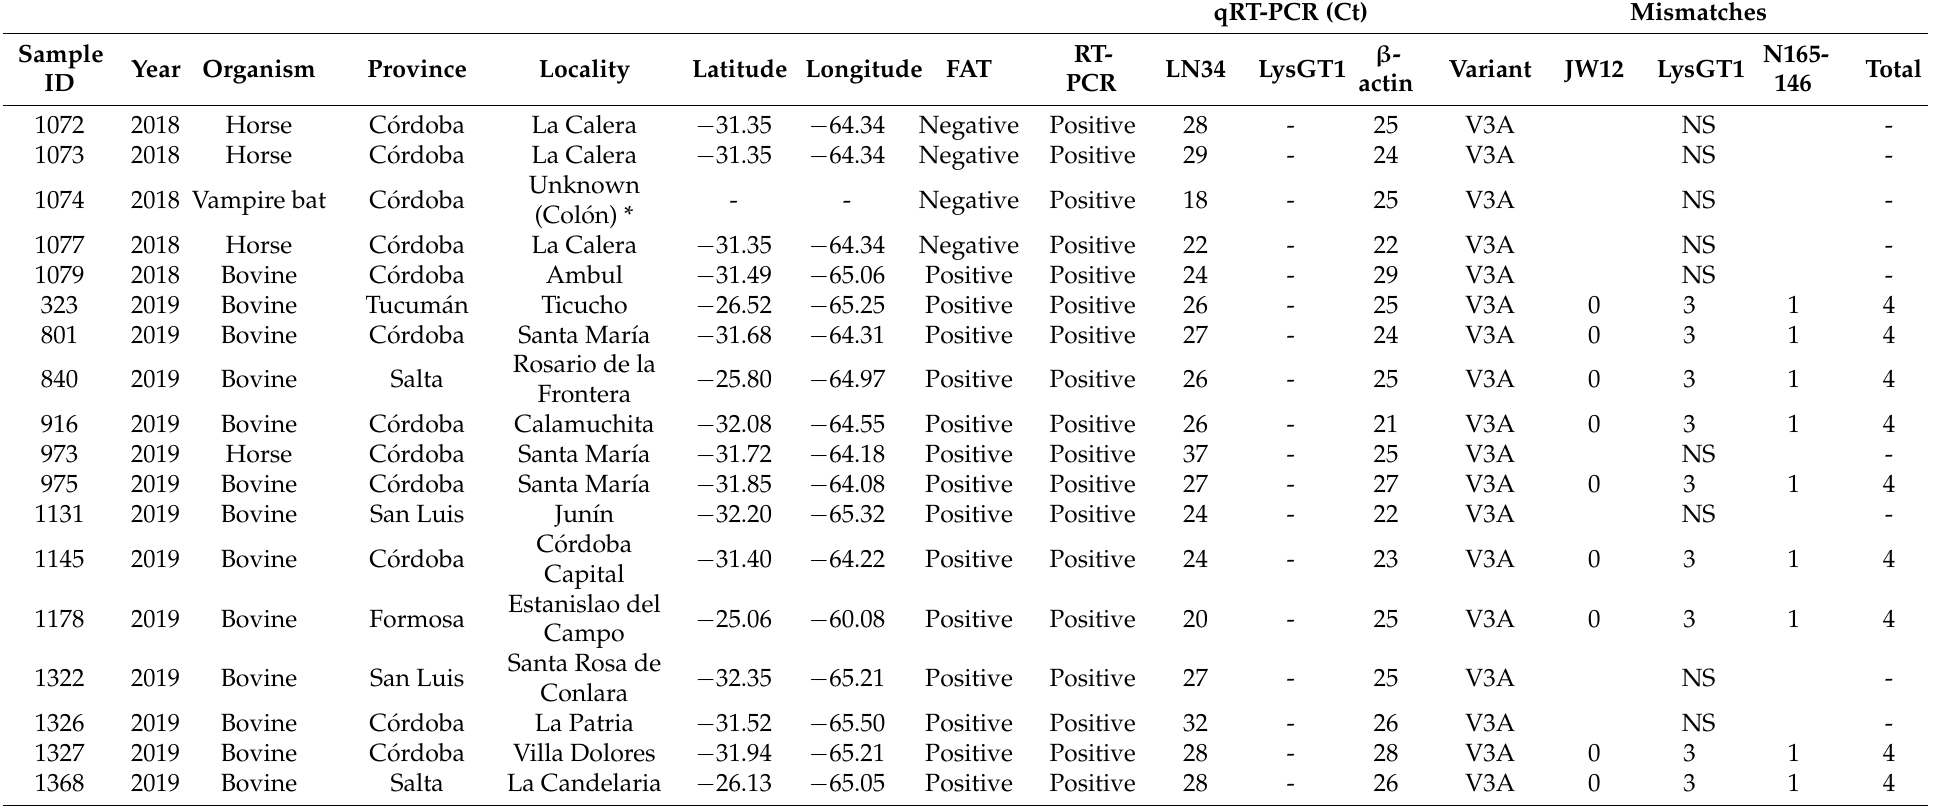
Table 1. Samples characterized as V3 and V3A analyzed in this study. Source, year of submission, place of origin, Direct Fluorescent Antibody Test (FAT), RT-PCR, and qRT-PCR results are shown. The number of mismatches in the primers/probe region of the LysGT1 oligos is shown